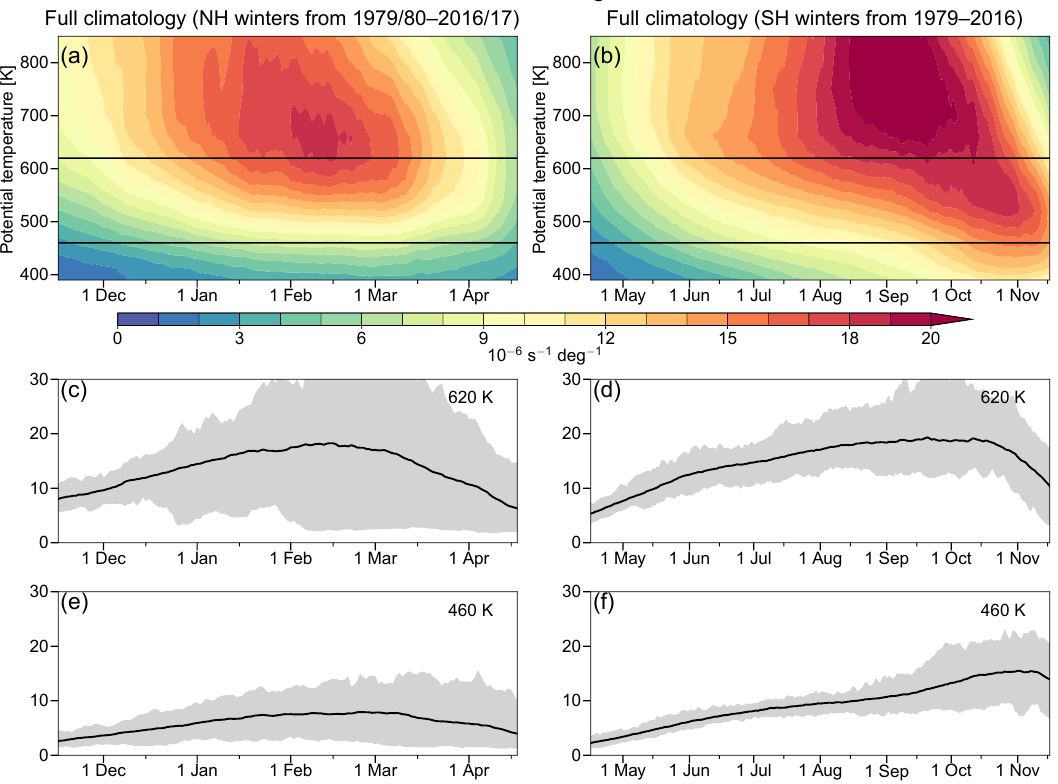
Figure 9. As in Fig. 3 but for maximum sPV gradients. The color range in panels (a) and (b) is from 0 to 20 scaled PV gradient units (PVGUs) (blues to reds), with all values over 20 shown in the deepest